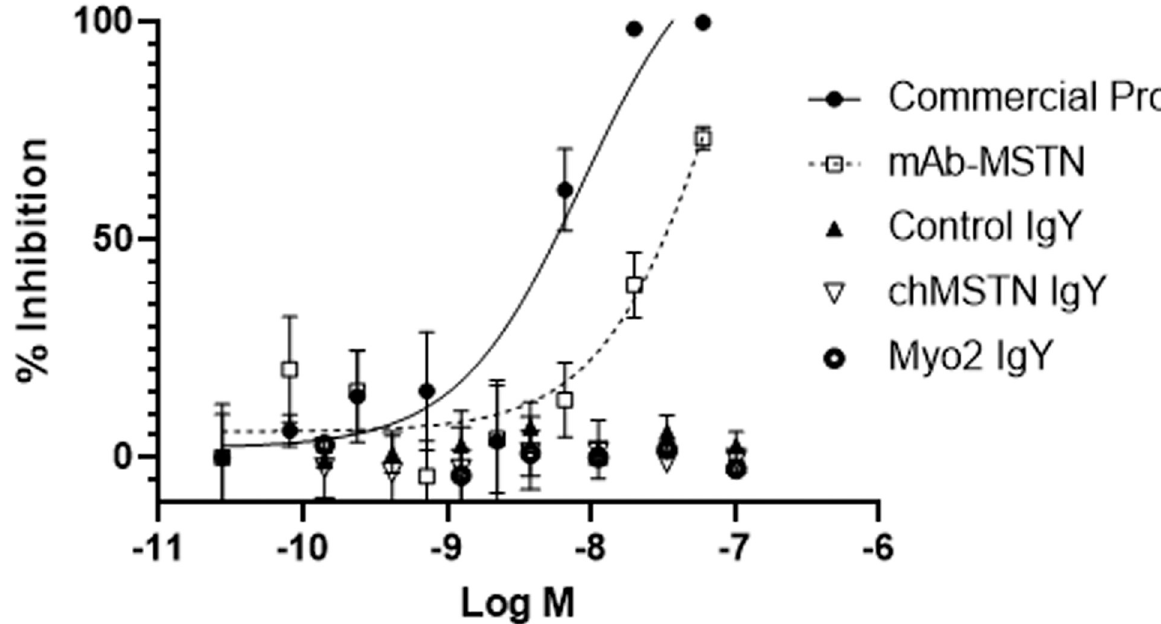
Fig 6. Inhibition of MSTN activity by egg yolk IgY. HEK293 cells stably expressing (CAGA) 12 - luciferase gene construct were seeded on a 96-well culture plate at 35,000 cells/well and grown for 24 h in DMEM with 10% fetal calf serum, antibiotics, and antimycotic. The medium was removed, and various concentrations of commercial MSTN propeptide (Commercial Pro), monoclonal anti-MSTN antibody (mAb-MSTN), egg yolk IgYs from the Control, chMSTN, and Myo2 groups in DMEM containing 1 nM MSTN were added to each well, followed by incubation for 24 hr. The medium was removed, luminescence substrate was added, followed by luminescence measurement. The % inhibition of MSTN activity was calculated by the following formula: % inhibition = (luminescence at 1 nM MSTN—luminescence at each ligand concentration) �